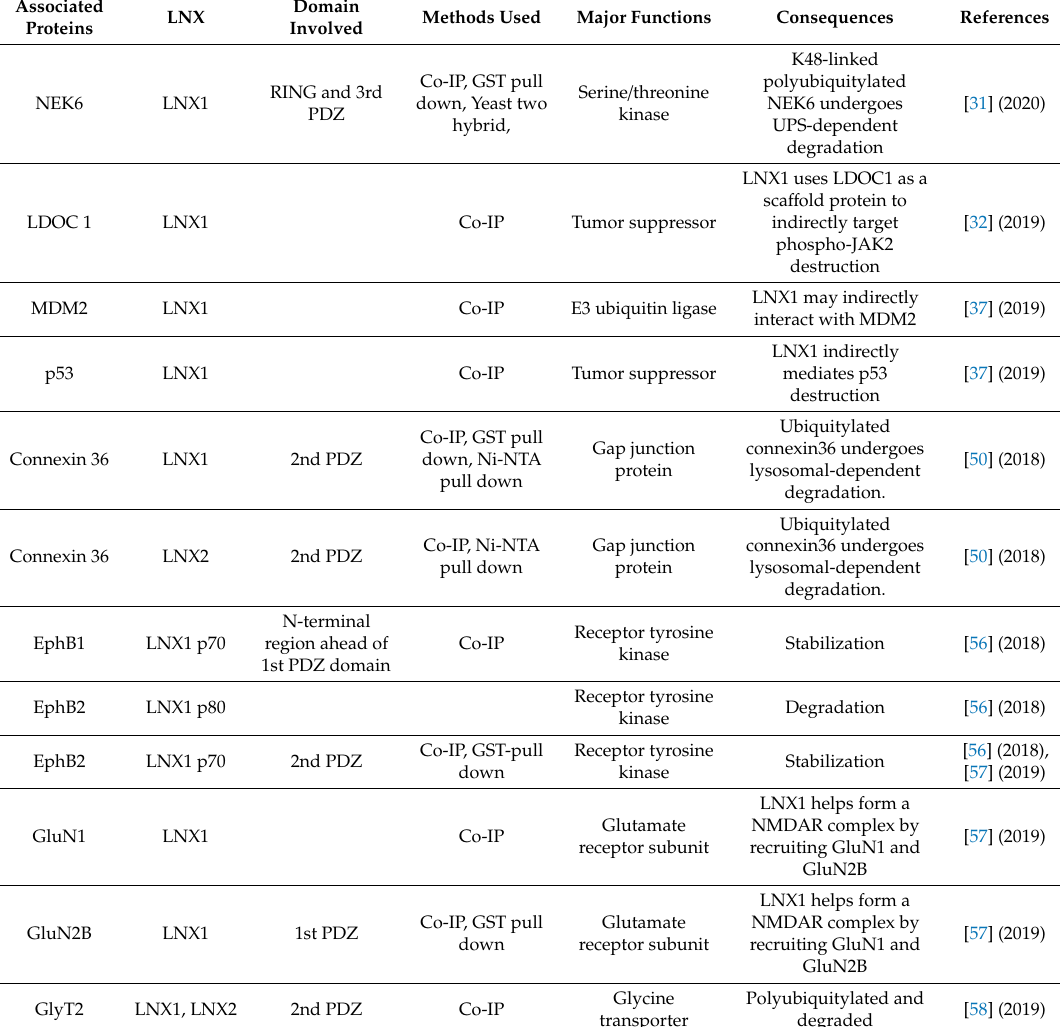
Table 2. Newly discovered LNX1 and LNX2 associated proteins in the past three years (2018–2020). Associated